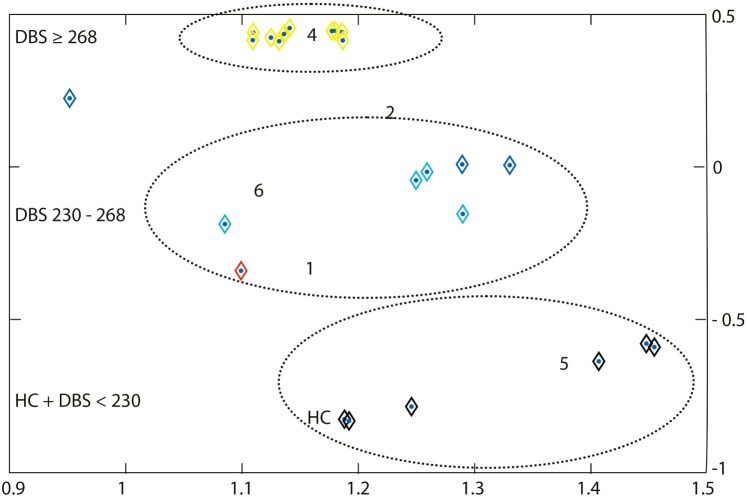
A region-of-interest cluster analysis of the nucleus caudatus was performed with fuzzy clustering to associate this subregion to a cluster representative for each group. The cluster analysis of the patients and controls was performed according to the MR parameter subset (T2f, SDf, kf, kr, T2r), given a maximal number of six classes. Each subgroup (symptomatic, presymptomatic, and control) consists of 10 persons. Cluster 4 represents subjects with a disease burden score (DBS) of ≥268 (yellow), it includes all symptomatic Huntington’s disease patients and one non-symptomatic gene carrier. Cluster 5 represents the non-symptomatic gene carrier with DBS <230 and controls (black). Clusters 1, 2, and 6 (red, light and dark blue) essentially represent transition zones consisting of presymptomatic patients with DBS values increasing with decreasing distance from cluster 4. Cluster 3 is empty. The axes correspond to the largest eigenvalues found by the principal component analysis.